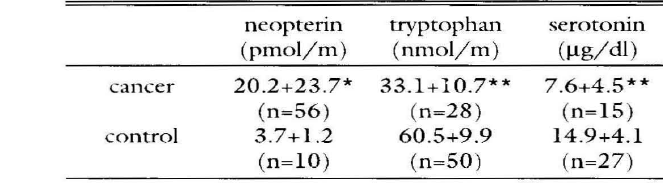
Table 1. Serum levels of neopterin, tryptophan and sero tonin 111 patients with advanced cancers and normal